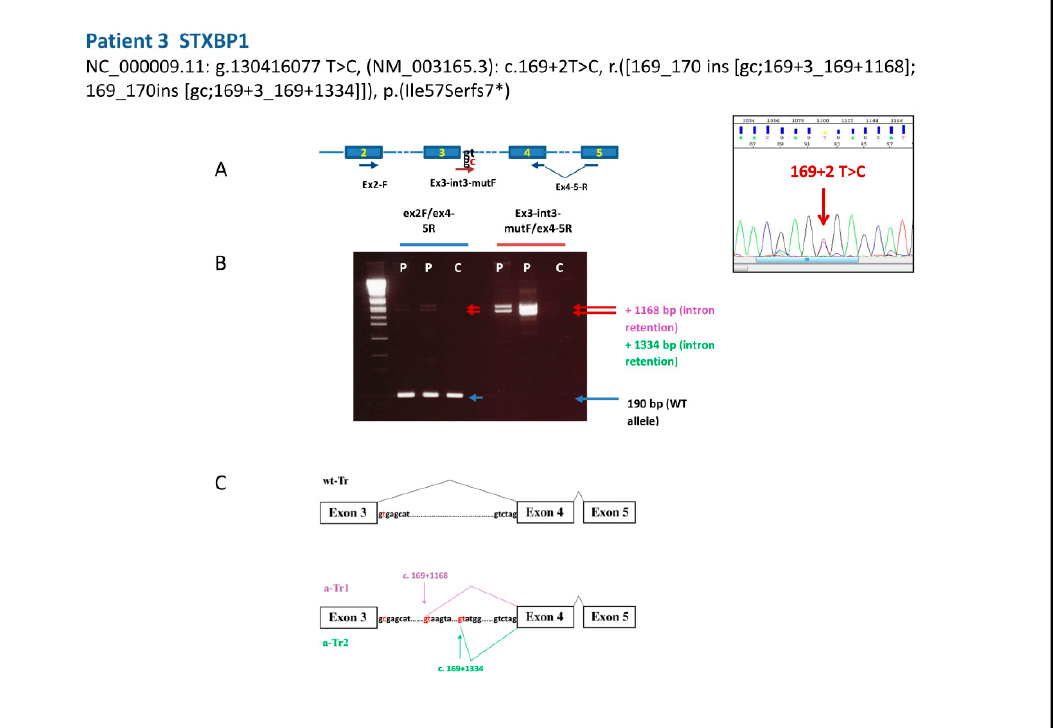
Figure 1. ( A ) Schematic representation of STXBP1 gene primer pairs used for characterization of patient 3 variant and on the right the electropherogram with the heterozygous variant. ( B ) The 2% agarose gel shows the wt amplicon of 190 bp in the first PCR (ex2F/ex4–5R) (blue arrow) and a weak signal of two aberrant fragments only in the proband (P). Two long amplicons obtained by a primer pair selective for the aberrant transcript (Ex3-int3-mutF/ex4–5R) are well visible in the proband’s lanes (P) (red arrows) and not in the control DNA lane ( C ). ( C ) Schematic of the mis-splicing caused by the c.169 + 2T> C mutation inferred by sequencing of the two amplicons that correspond to two aberrant intron-retaining transcripts resulting from the use of two alternative donor sites (in red) 1168 and 1134 nt downstream from the end of exon 3.